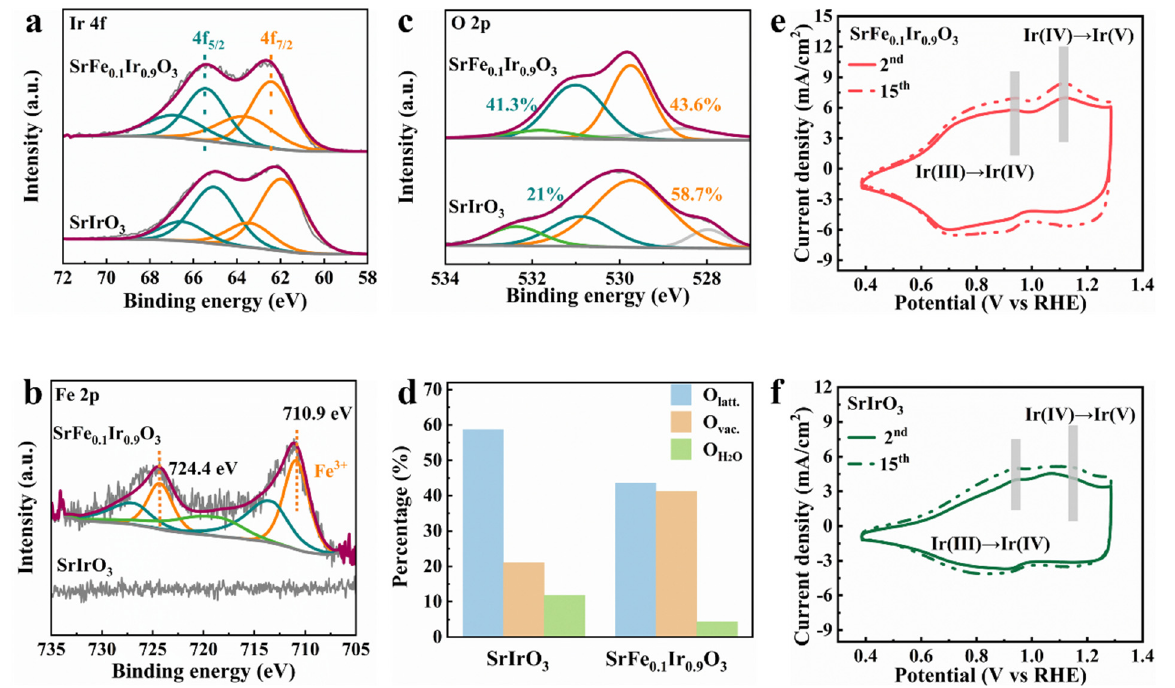
Figure 3. ( a ) Ir 4f, ( b ) Fe 2p, and ( c ) O 2p XPS spectra of SrIrO 3 and SrFe 0.1 Ir 0.9 O 3 . ( d ) Result of O 1s orbital XPS spectra of SrIrO 3 and SrFe 0.1 Ir 0.9 O 3 . The cyclic voltammetry (CV) curves recorded at the 2nd and 15th cycles for ( e ) SrIrO 3 and ( f ) SrFe 0.1 Ir 0.9 O 3 .